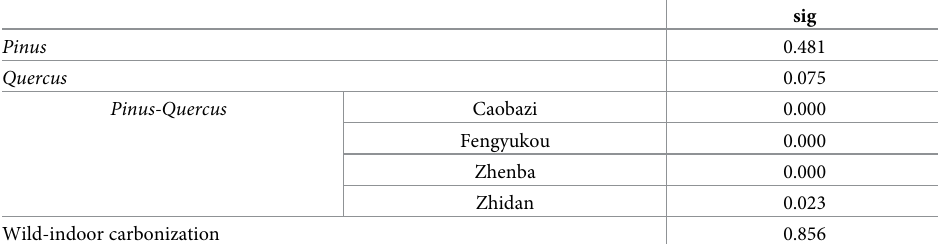
Table 3. Nonparametric tests for wood